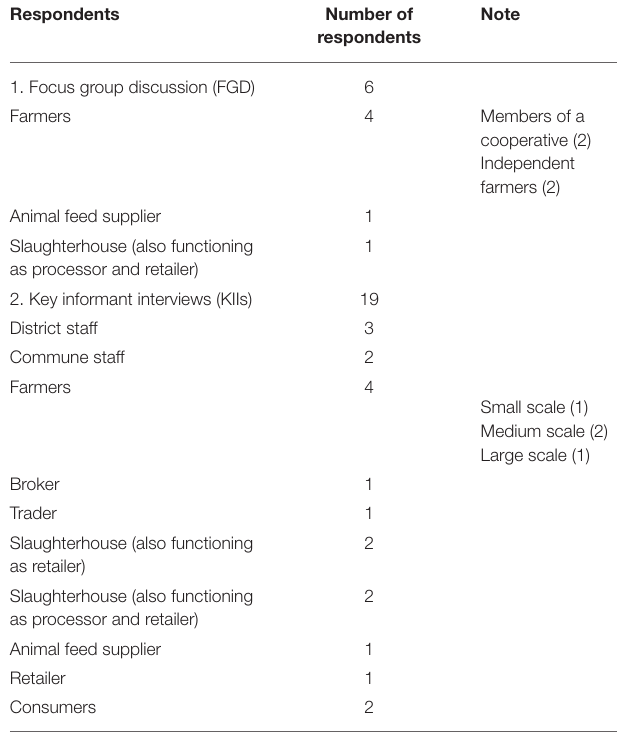
TABLE 1 | List of participants of focus group discussion and key informant